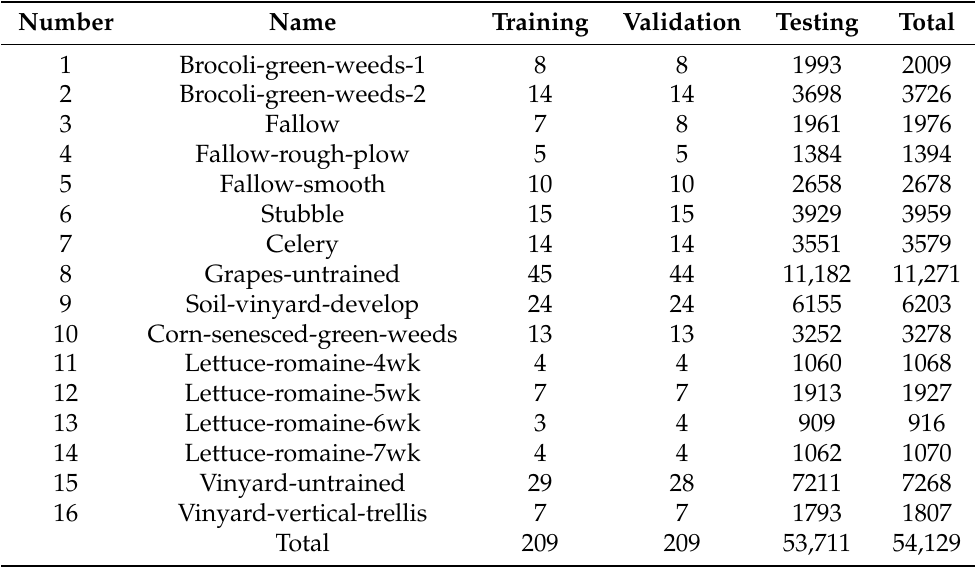
Table 2. Training, validation, and testing sample numbers in Salinas.